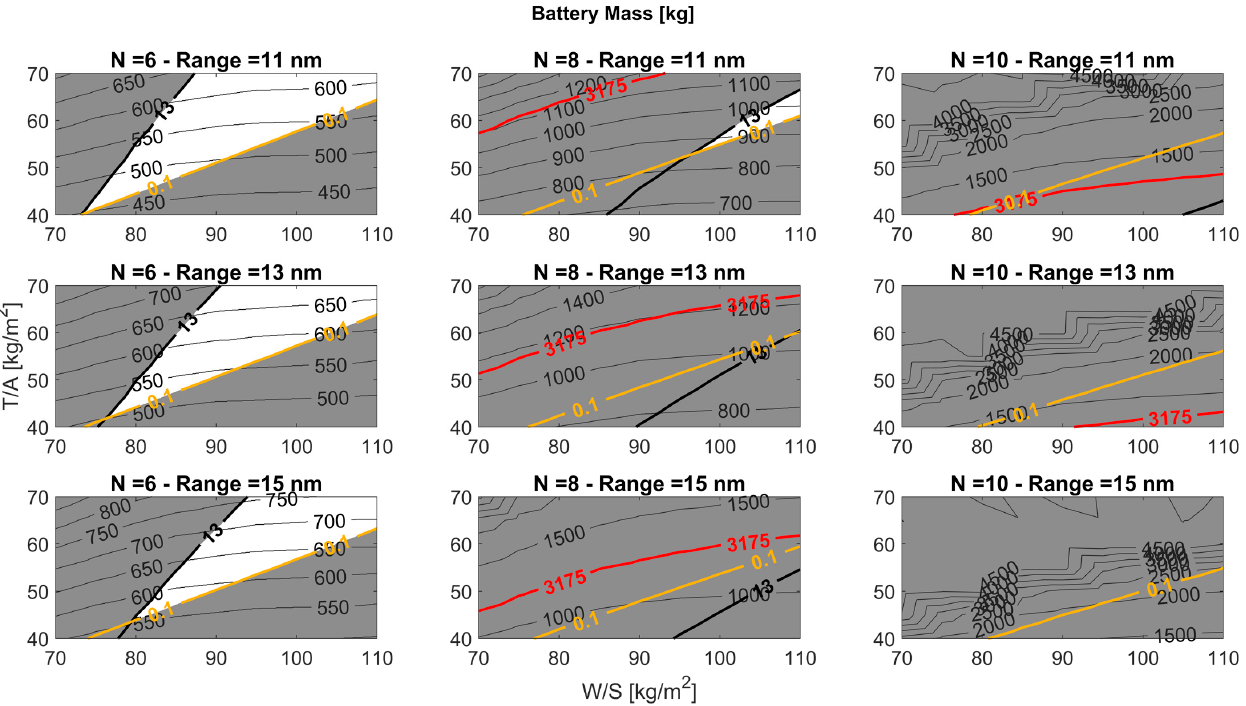
Figure 18. W/S vs. T/A charts of battery mass (future technology) varying number and range of typical missions. Each plot shows a highlighted area, which identifies the design space compliant with the constraints.